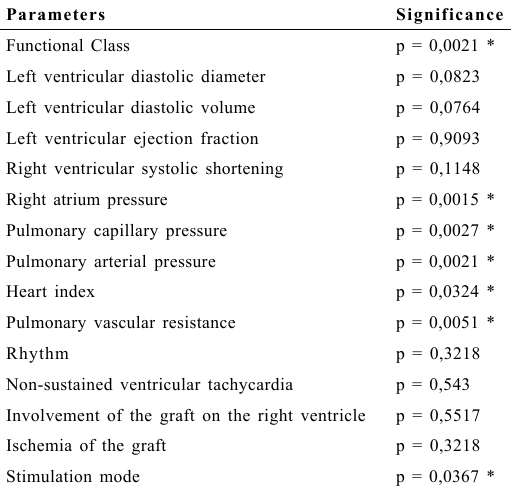
Table 3. Correlation of the pre-, intra- and post-operative factors with morbid events by progressive heart disease after dynamic cardiomyoplasty. P-values < 0.05 (asterisk) were considered significant.